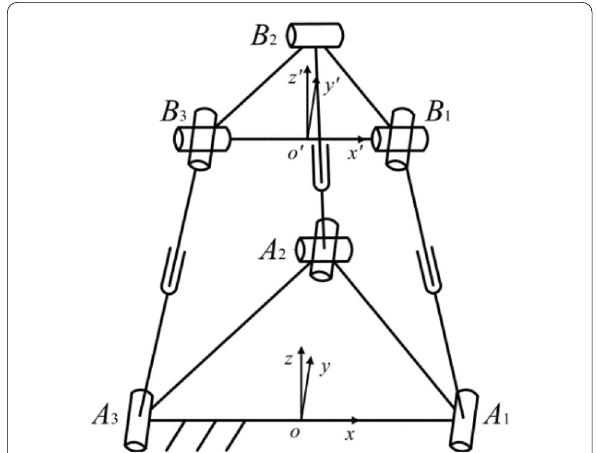
Figure 1 Sketch of the rigid RPR